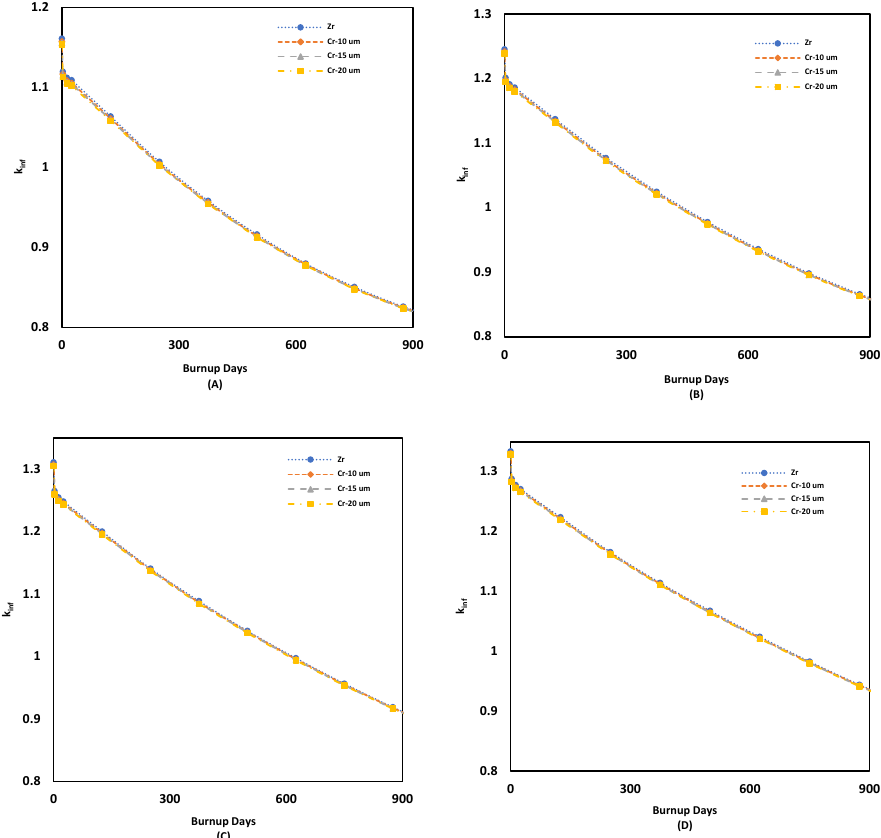
Figure 3. Unit cell infinite multiplication factor vs. burnup days with different enrichments: ( A ) 1.68 wt %, ( B ) 2.64 wt %, ( C ) 3.14 wt %, ( D ) 3.46 wt %.